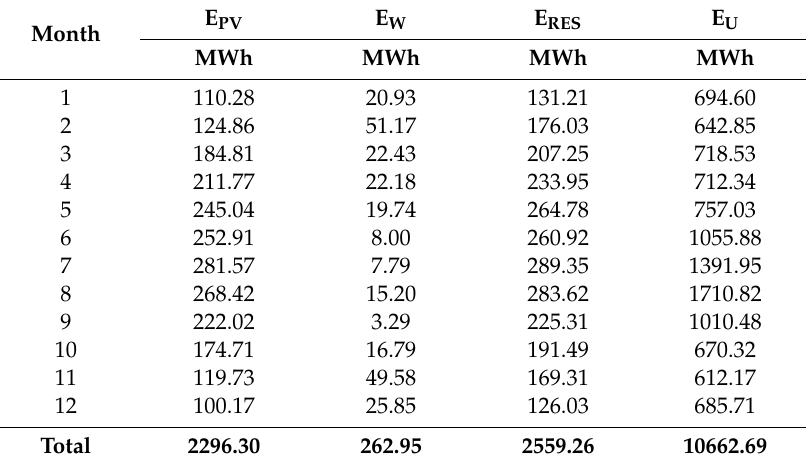
Table 4. Monthly RES energy